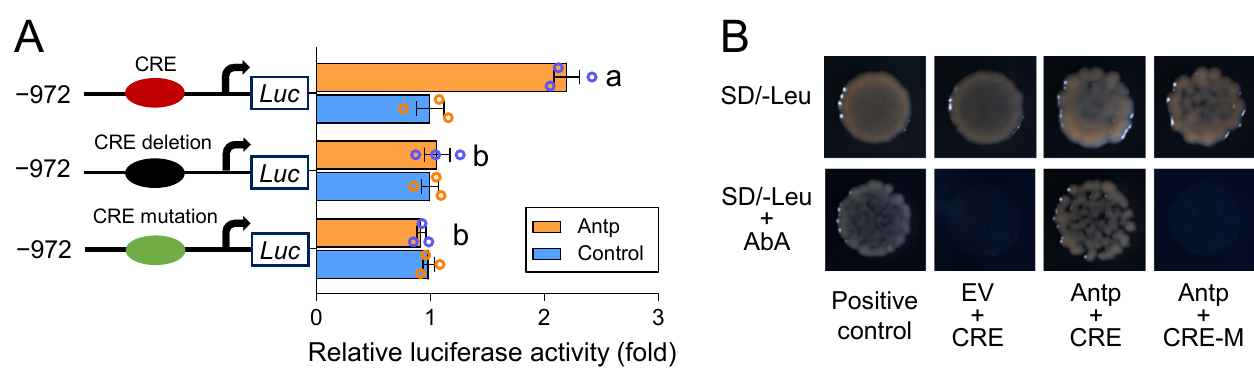
Figure 4. Antp positively regulates PxABCG1 promoter activity through the CRE. ( A ) Effect of Antp on the activity of the PxABCG1 promoter with either a deletion or a mutation in the CRE. The CRE (TAATTAA, − 932 to − 925) in P(-972/-1)-S1 was deleted or mutated to TAAGTAA. Antp was cotransfected with P(-972/-1)-S1 containing a normal CRE (red ellipse), lacking a CRE (black ellipse), or containing a mutant CRE (green ellipse). The empty pAc5.1 vector was used as a control. One-way ANOVA followed by Duncan’s test was used for statistical analysis ( p < 0.05). Different letters on the bars indicate significant differences. ( B ) Investigation of the direct interaction between Antp and the CRE using a Y1H assay. Bait vectors containing three tandem repeats with the normal or mutant CRE and a prey vector containing Antp were transferred into the Y1HGold yeast strain. The yeast was grown on SD/-Leu selective medium with or without AbA. EV, empty prey vector; positive control, pGADT7-p53 +